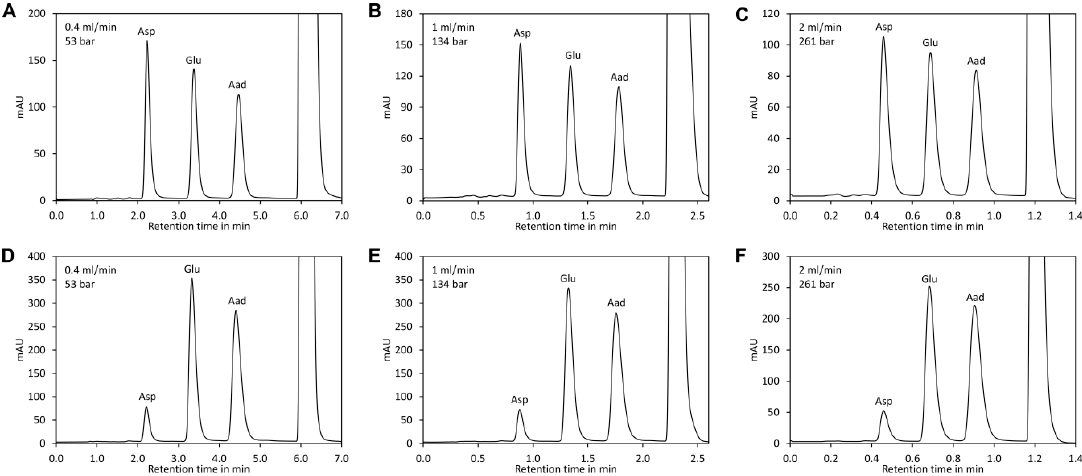
Figure 3. Impact of the flow rate on separation. A sample of standard containing equimolar amounts of aspartic acid (Asp), glutamic acid (Glu), and 2-aminoadipic acid (Aad) was derivatised with DNFB and analysed by UHPLC with a flow rate of ( A ) 0.4 mL/min, ( B ) 1 mL/min and ( C ) 2 mL/min. The injection volume was 5 µL. A tomato sample was derivatised with DNFB and analysed under the same conditions: ( D ) 0.4 mL/min, ( E ) 1 mL/min, and ( F ) 2 mL/min. The injection volume was 2 µL.